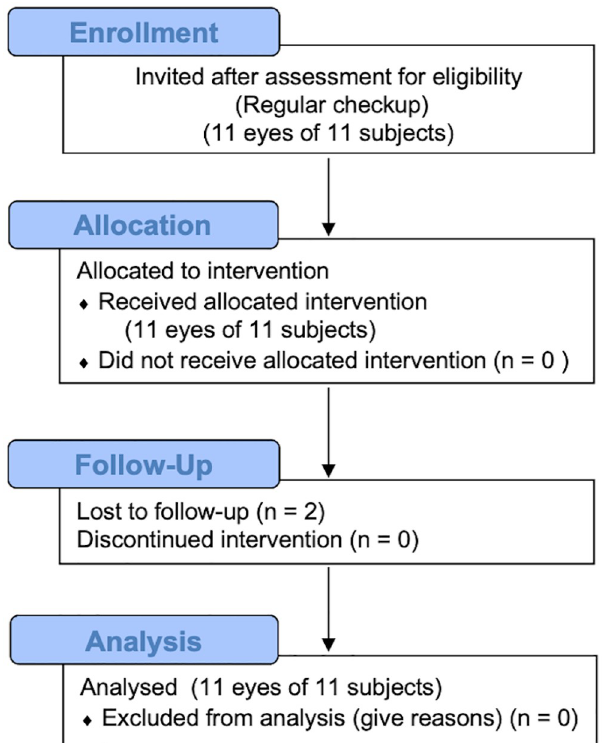
Fig 1. CONSORT 2010 flow diagram. (DME patients). This study included 11 eyes of 11